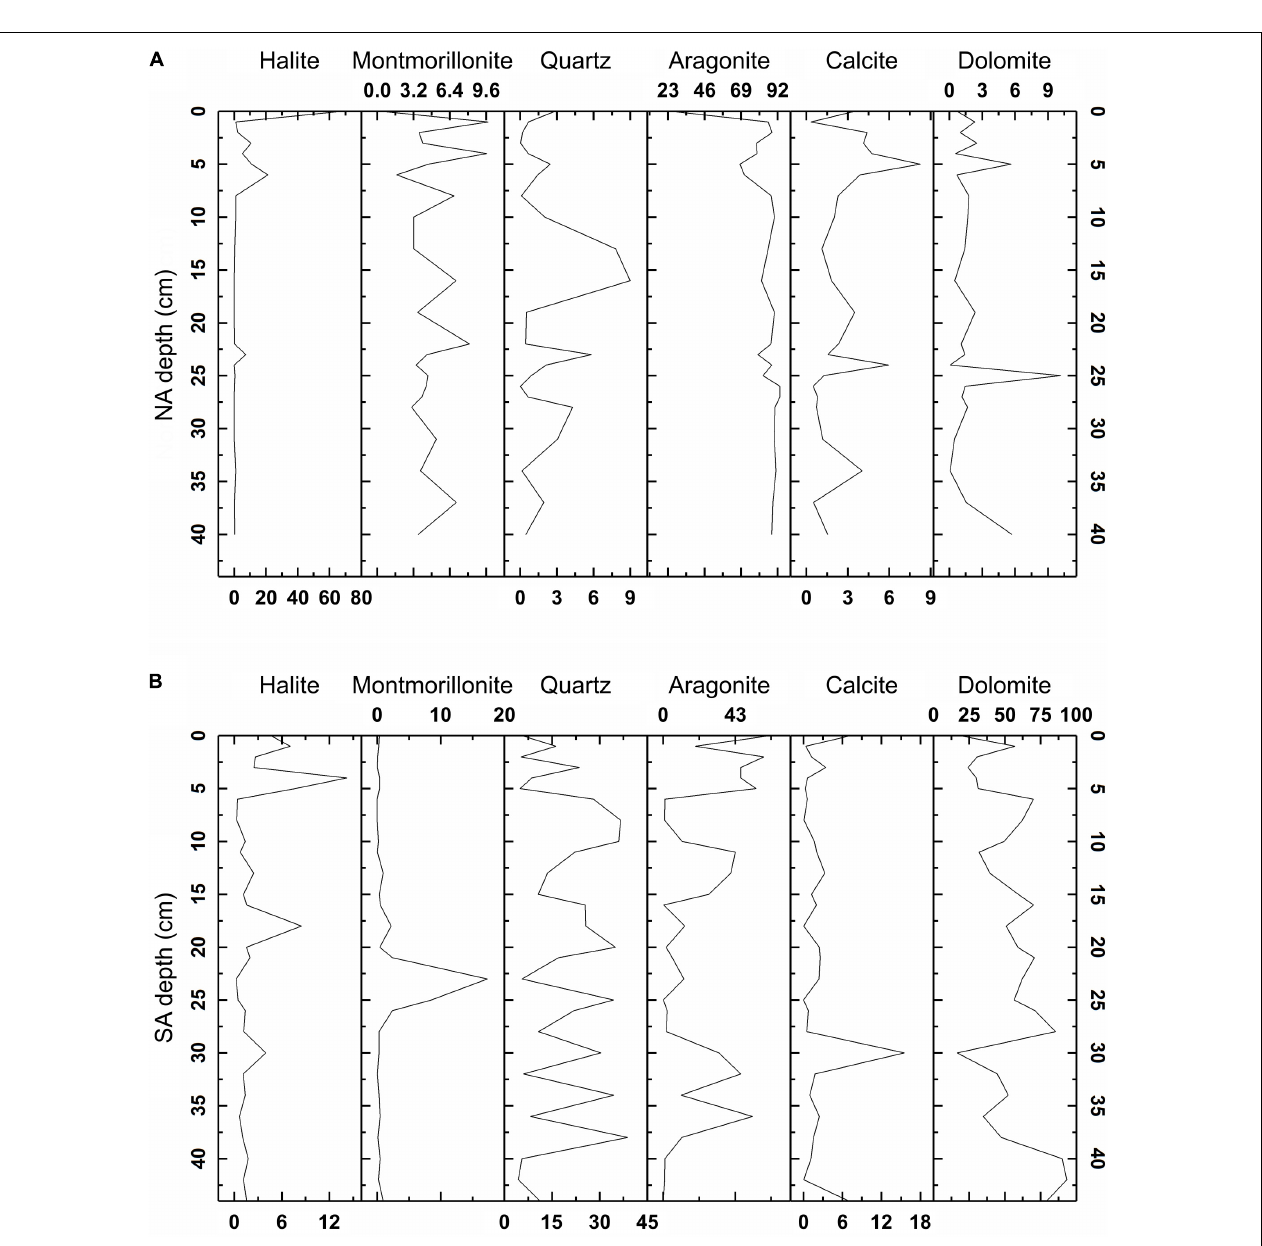
FIGURE 3 | Mineralogical composition of sediment columns from the North Arm (NA, A ) and South Arm (SA, B ), as determined via X-ray diffraction (XRD) data analysis with Jade 9 software. Representative spectra are depicted in Figure 2 .